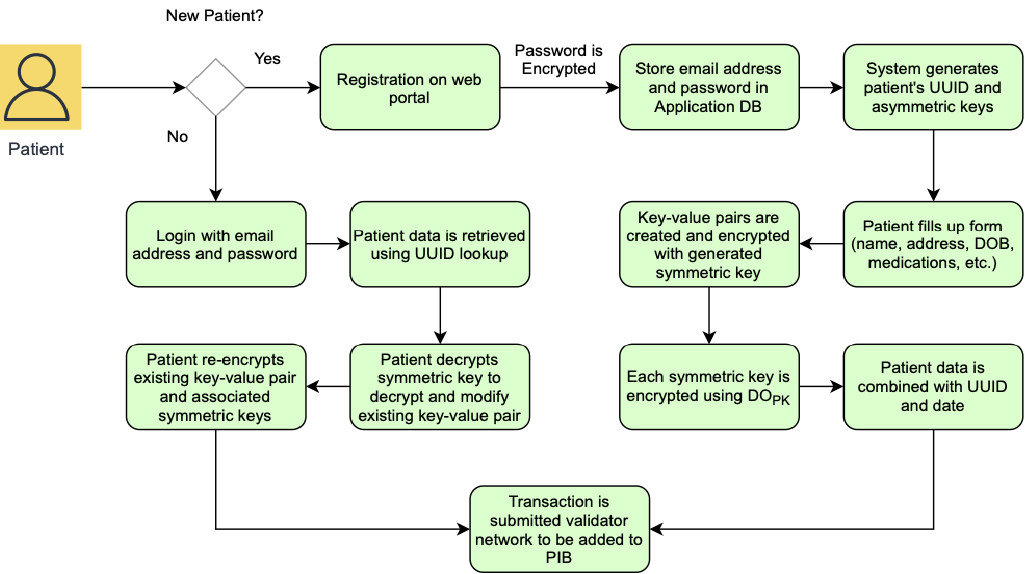
Figure 10. Patient registration and information retrieval flow diagram.